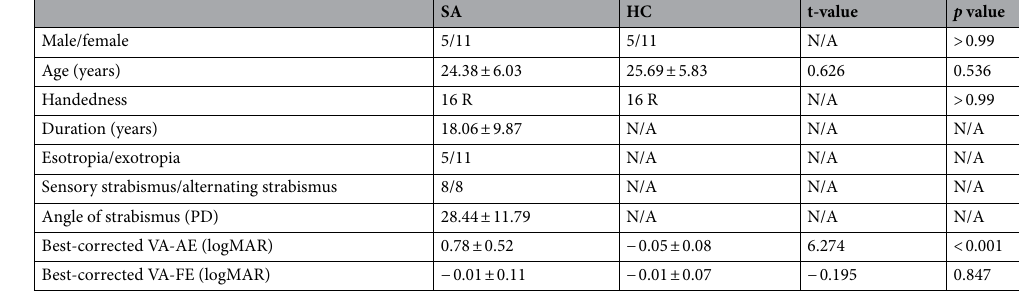
Table 1. Demographics and clinical measurements of SA and HC groups. Independent t-tests comparing the two groups ( p < 0.05 represented statistically significant differences). Data shown as mean standard deviation or number. SA strabismus with amblyopia, HC healthy control, N/A not applicable, PD prism diopter, VA visual acuity, AE amblyopic eye, FE fellow eye, R